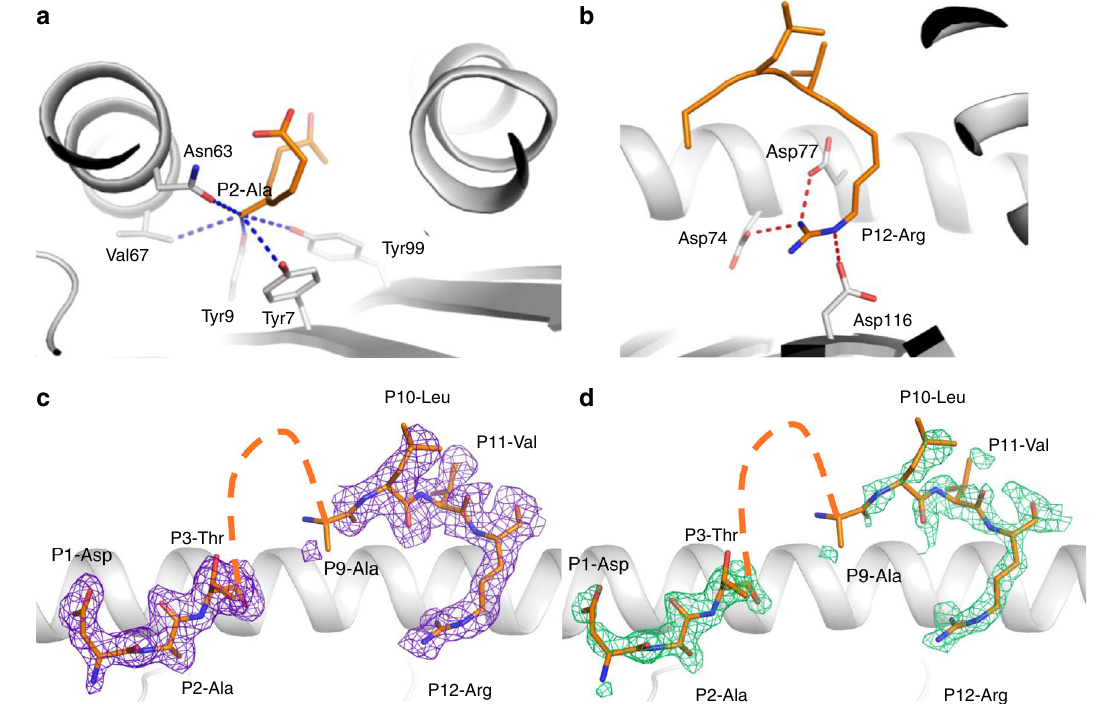
Fig. 1 Structure of the HLA-A*68:01-NP 145 complex. Structure of the HLA-A*68:01 (white cartoon) bound to the NP 145 peptide (orange stick). a A zoomed view of the P2-Ala anchor residue interaction with the HLA-A*68:01 molecule, the blue dashed lines represent hydrophobic interactions. b The P12-Arg salt bridge network (red dashed lines) with the HLA-A*68:01 amino acids. c , d The electron density maps after re fi nement ( c 2Fo-Fc map colored in purple and contoured at 1 σ ) or before building the peptide in d (Fo-Fc or omit map colored in green and contoured at 3 σ ). The orange dashed line on c , d represent the missing amino acid from the NP 145 peptide (P4 – P8) in the crystal